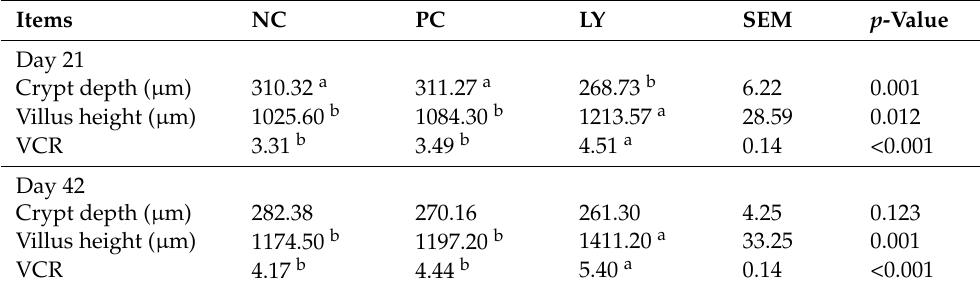
Table 8. Effect of dietary treatments on the jejunum morphology of